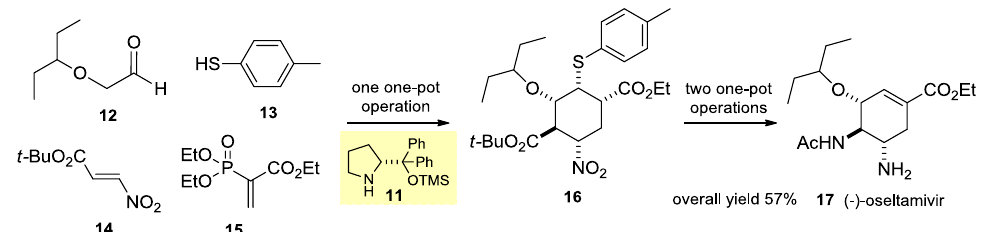
Figure 6. Oseltamivir enantioselective synthesis, see Ref. [34].